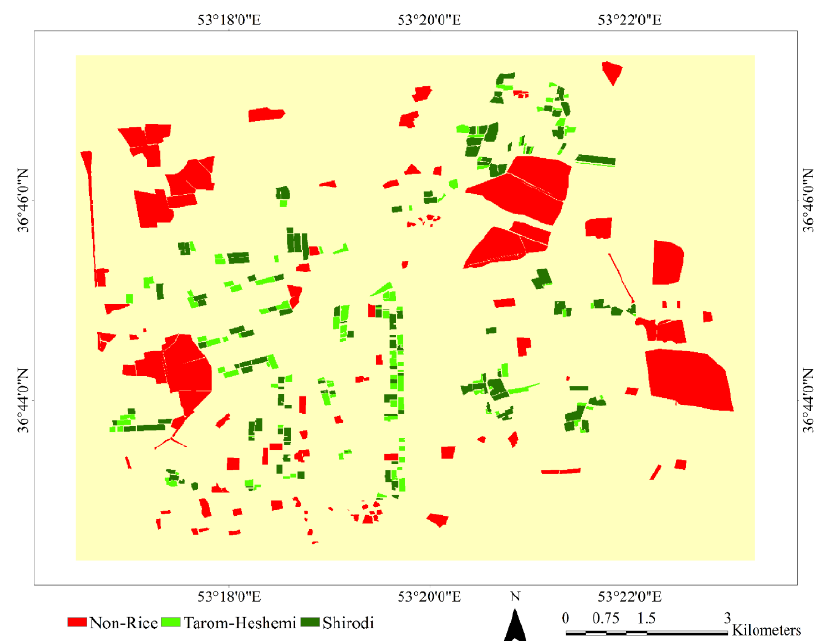
Figure 3. Distribution of the in-situ samples of ten classes for training and testing.